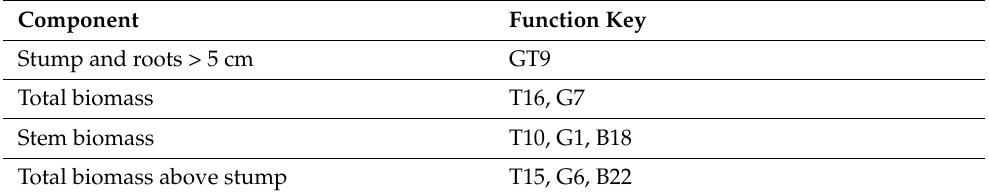
Table 3. The key to functions in [53] and the corresponding biomass component where T, G, and B are used for pine, spruce, and deciduous trees,